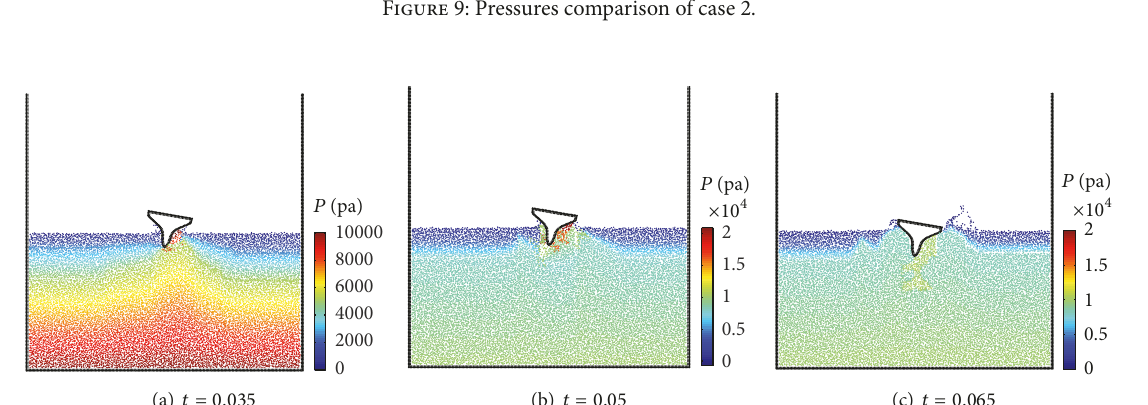
Figure 9: Pressures comparison of case 2.